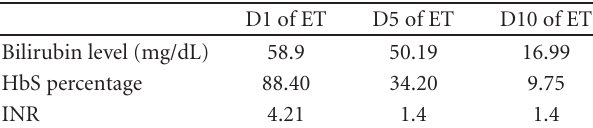
Table 1: Evolution of bilirubin, HbS percentage, and INR with exchange transfusion (ET).